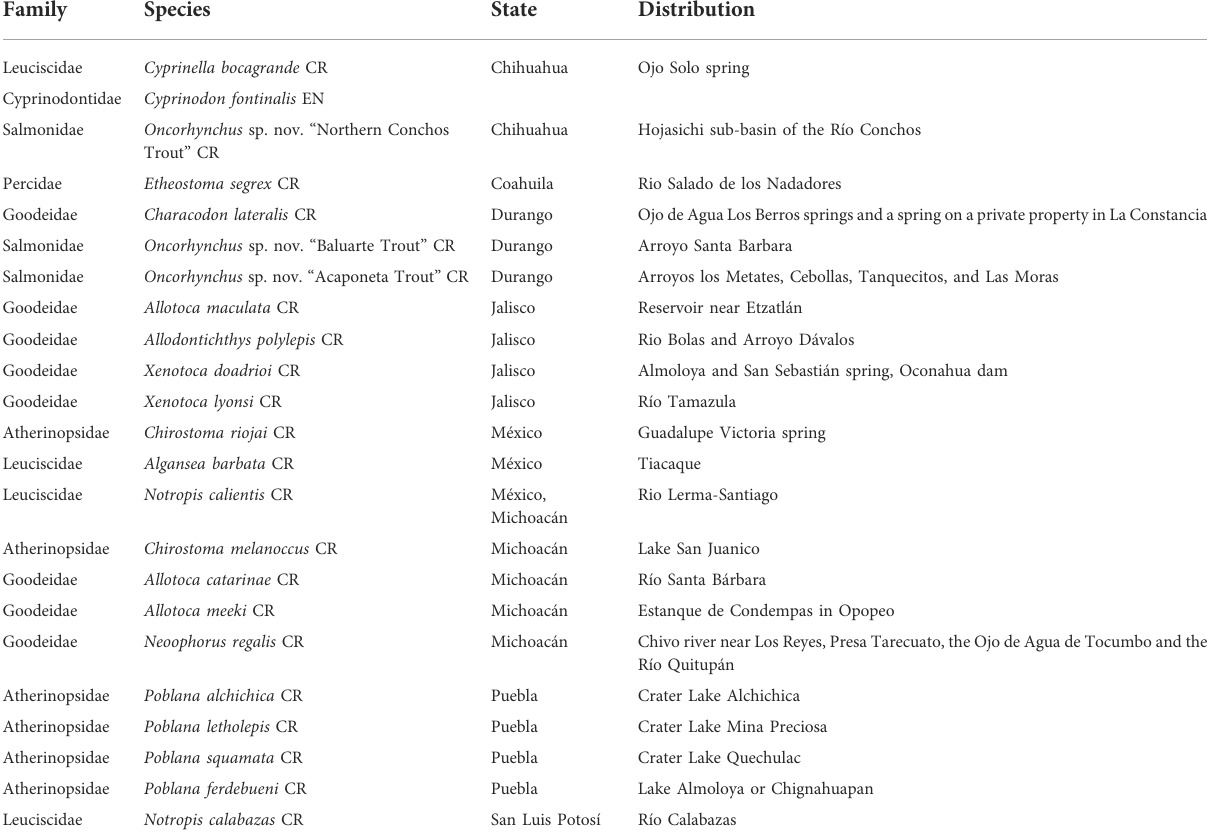
TABLE 4 List of CR + species inhabiting sites with no management or protection. Family Species State Distribution